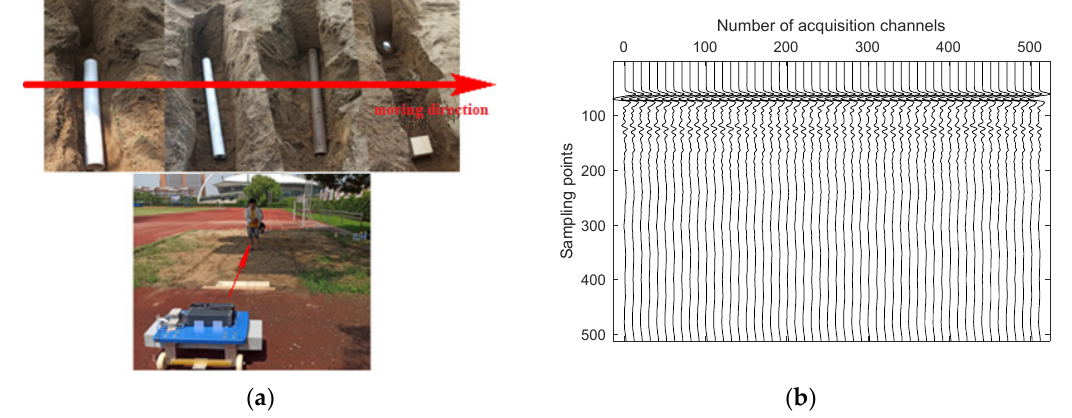
Figure 1. Detection of buried targets by ground penetrating radar. ( a ) Schematic diagram of GPR measurement. ( b ) Time accumulation diagram.